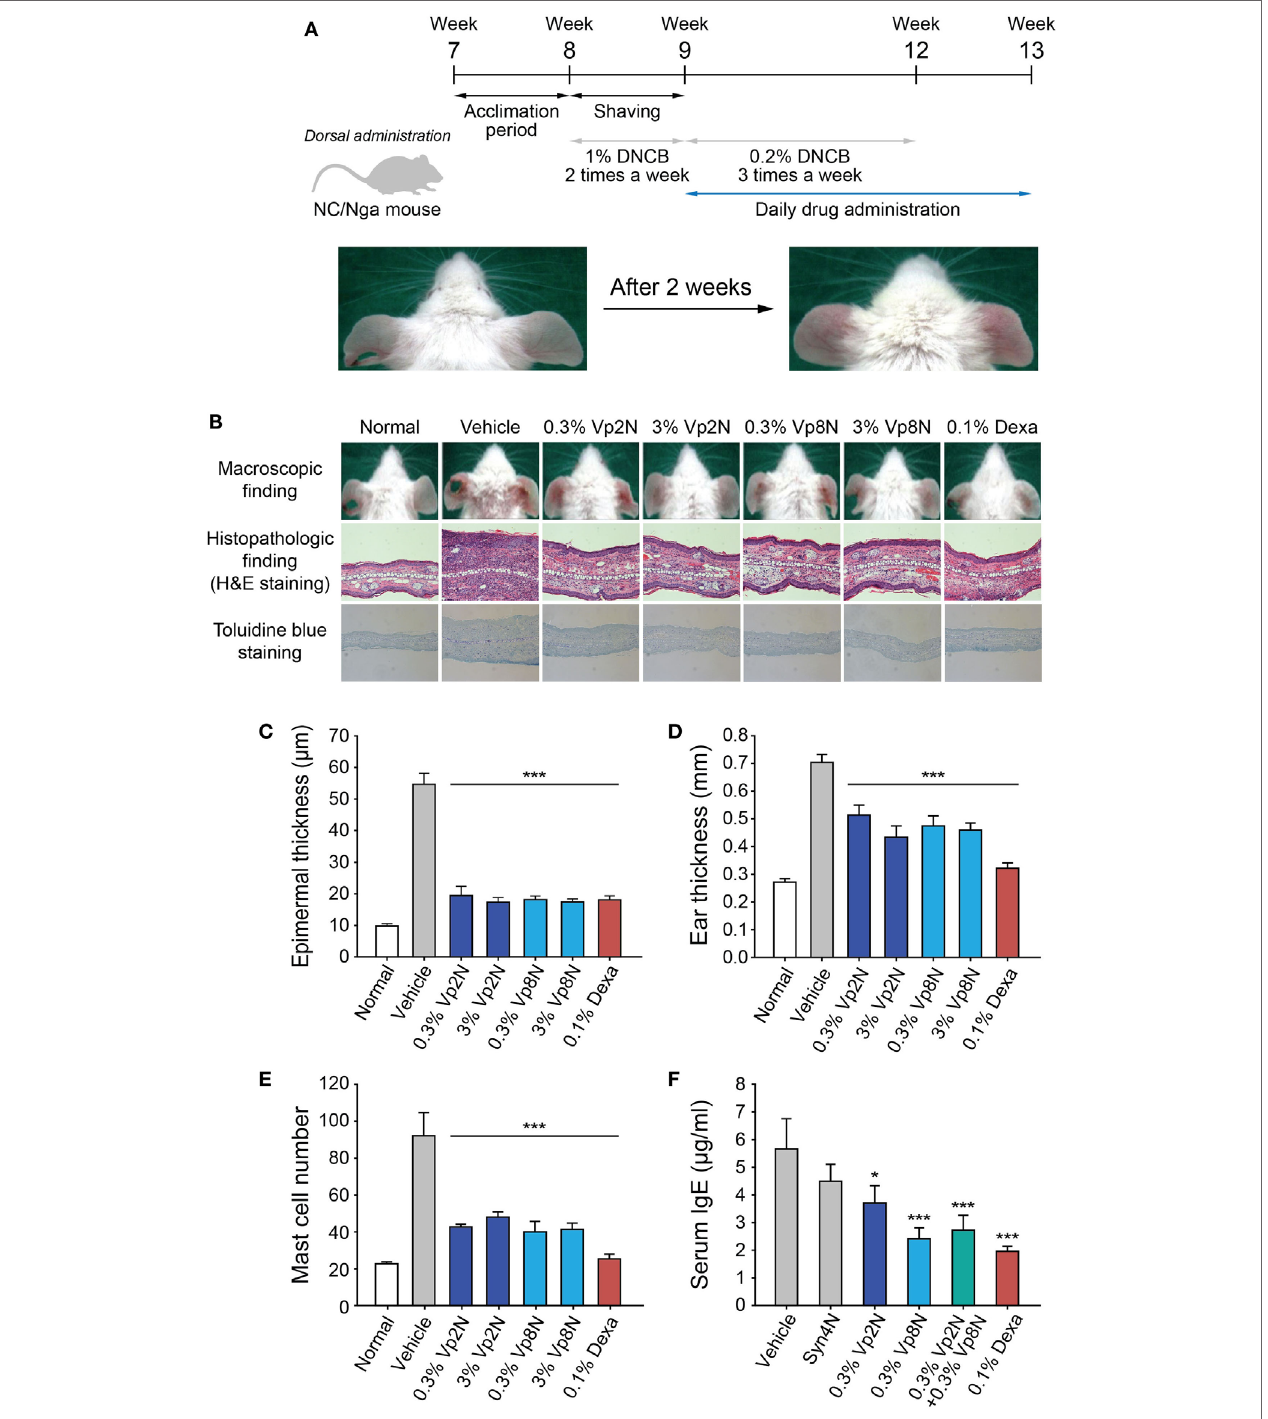
FigUre 5 | Efficacy of N-terminal-mimicking peptides for treating the DNCB-induced atopic dermatitis-like skin lesions of NC/Nga mice. (a) Experimental schedule for application of the experimental drugs to the dermatitis-like skin lesions induced in the NC/Nga mice. Following an initial sensitization step with 1% DNCB twice weekly for 1 week, the mice were dorsally treated with 0.2% DNCB thrice weekly for 3 weeks. The NC/Nga mice were daily treated with peptide drugs for 4 weeks starting from week 9. (b) The skin inflammation in the NC/Nga mice was reduced by the synthetic peptides. Macroscopic appearance of mice treated with synthetic peptides (upper panels) and histopathologic evaluation after the repeated application of synthetic peptides to the back skin of NC/Nga mice stained with hematoxylin and eosin (middle) or toluidine blue (lower). Epidermal thickness (c) , ear thickness (D) , the number of mast cells (e) , and the level of IgE (F) in serum were also evaluated. Dexamethasone (Dexa) was used as a positive control. Data are presented as the mean ± SD. * p < 0.05, *** p < 0.001 versus the control.